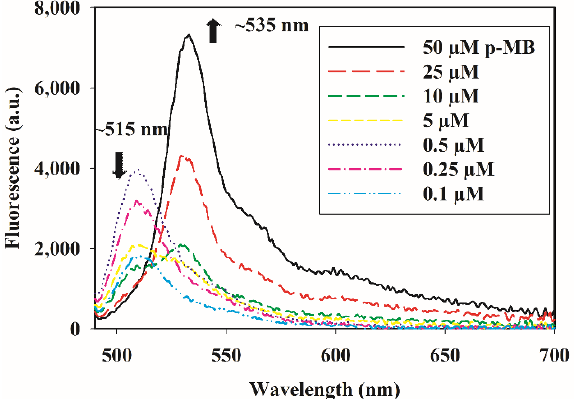
Figure 3. Effect of concentration on p-MB fluorescence in aqueous solution. The fluorophore stock solution in DMSO was diluted to the stated concentrations in 0.1 M PBS (0.15 M NaCl, pH 7.4). The excitation wavelength was 470 nm and the final concentration of DMSO in all solutions was 5% ( v / v ). Arrows denote the direction of change at the specified wavelengths as p-MB concentration increases. Note, however, that the decreasing fluorescence at 515 nm does not apply for the lower sub-micromolar concentrations. See Supplementary Material Figure S2 for spectra of sub-micromolar concentrations of p-MB (0.1–0.5 µM) without interference from the higher concentrations.